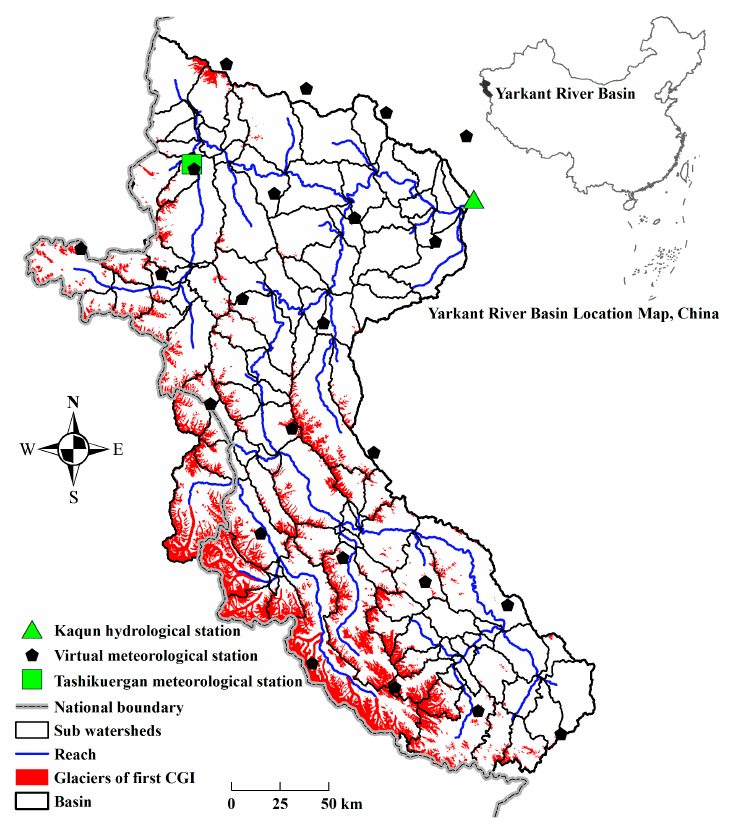
Figure 1. Location of the meteorological and hydrological sites with the grid points. GCI: China Glacier Inventory.